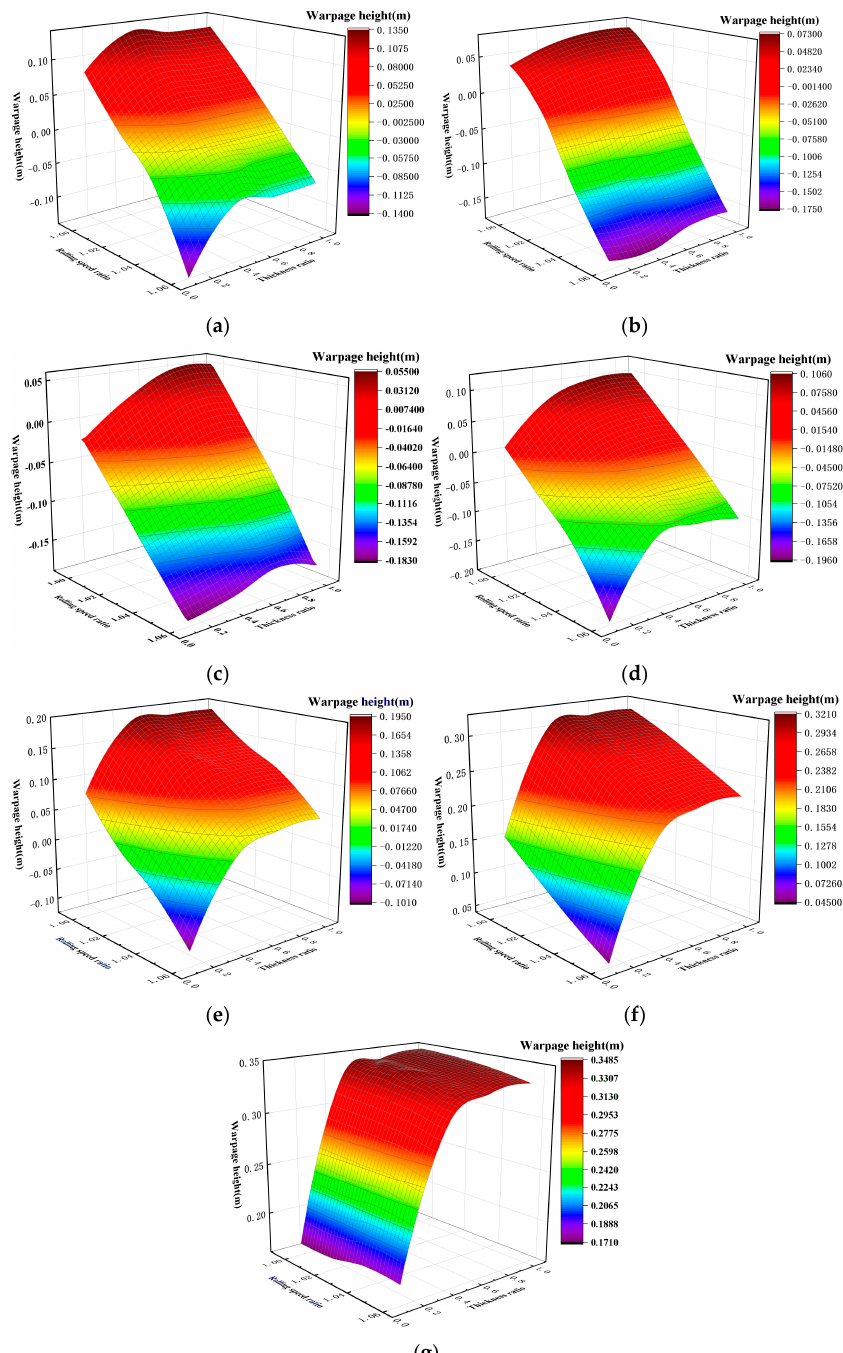
Figure 14. Simulation results showing the warpage height with different thickness ratios and different roll speed ratios. ( a ) Reduction ratio = 0.2, ( b ) reduction ratio = 0.25, ( c ) reduction ratio = 0.3, ( d ) reduction ratio = 0.35, ( e ) reduction ratio = 0.4, ( f ) reduction ratio = 0.45, ( g ) reduction ratio = 0.5.